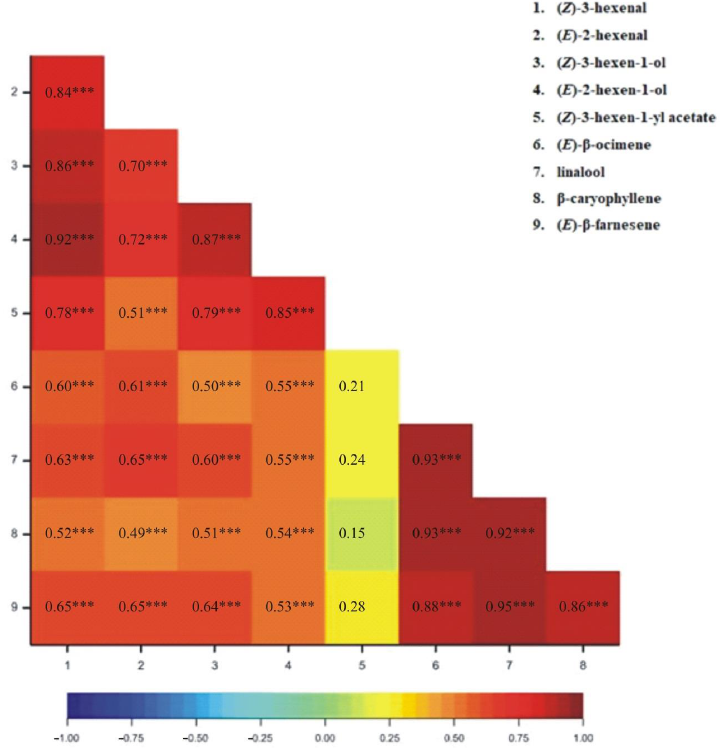
Figure 3. Heatmap for Pearson’s correlation coefficients between observed VOCs resulting from MJ-V treatment (*** p < 0.001).